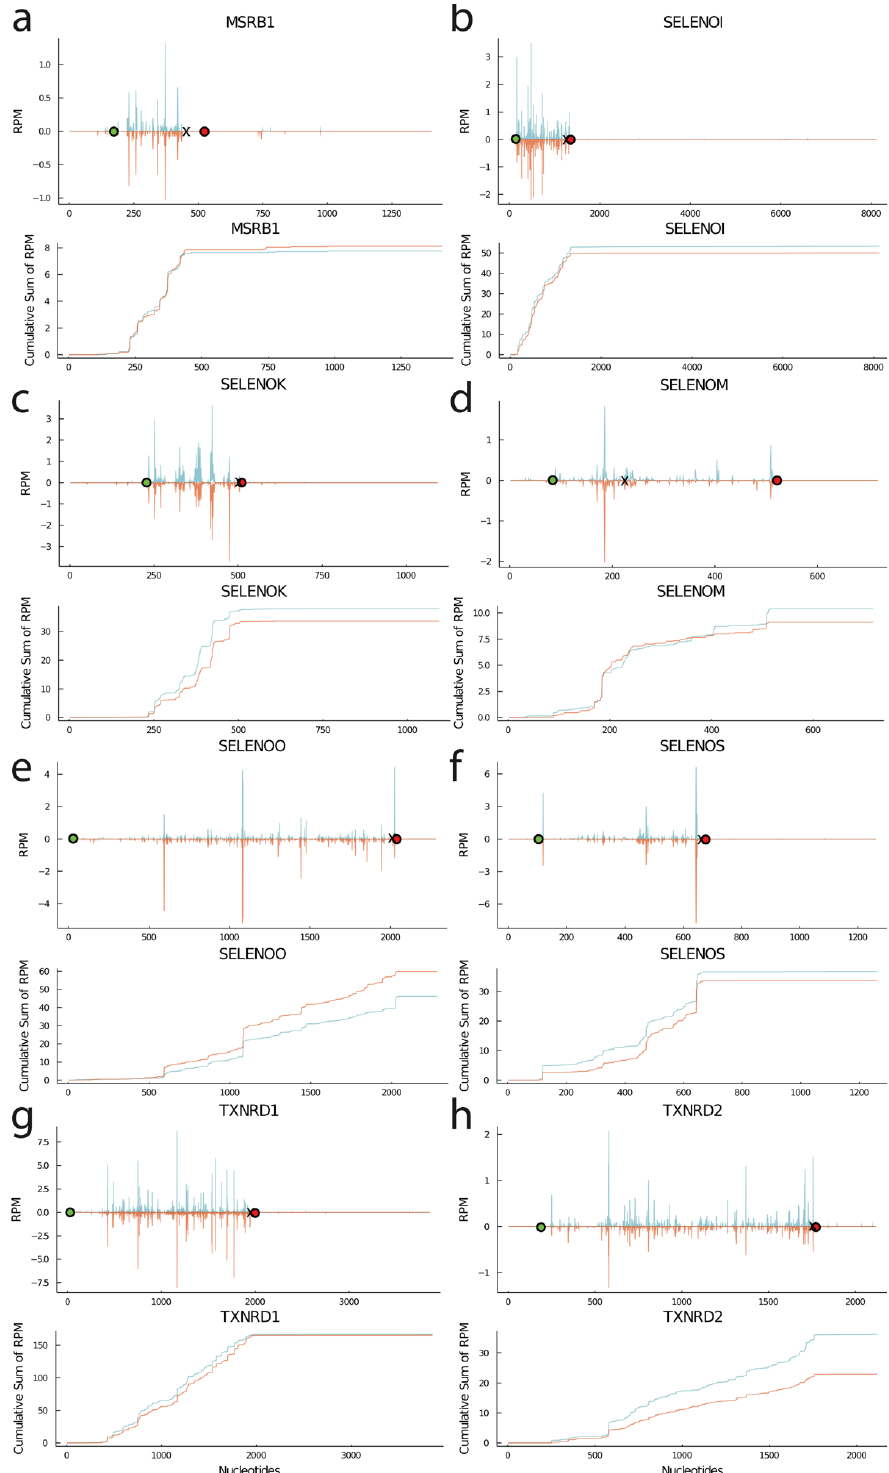
Figure A2. Ribosomal profiling in SECISBP2 -mutant HAP1 cells. ( a ) MSRB1, ( b ) SELENOI, ( c ) SELENOK, ( d ) SELENOM, ( e ) SELENOO, ( f ) SELENOS, ( g ) TXNRD1, and ( h ) TXNRD2 . The abundance of TXNRD2 RPFs is, interestingly, reduced despite the UGA/Sec in the penultimate